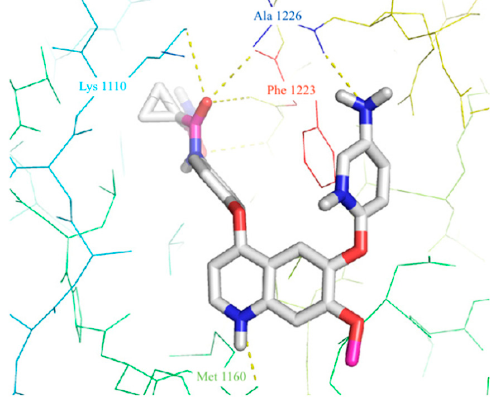
Figure 9. Main interactions of compound 28 with the amino acid residues in c-Met active site [59].